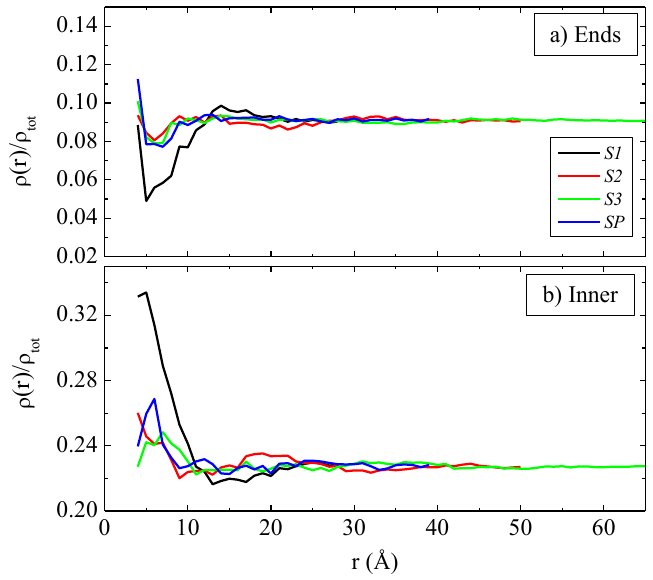
Figure 3. Mass monomer density profiles as a function of R (distance from the center of the graphene layer) based on ( a ) chain ends and ( b ) inner monomers of the polymer chain for the polymer/graphene nanocomposite